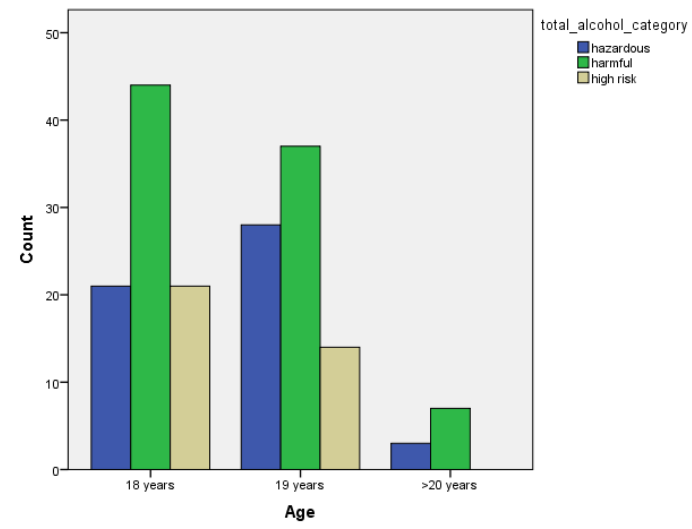
Figure 2. Frequency of tobacco and alcohol consumption depending on age (female).